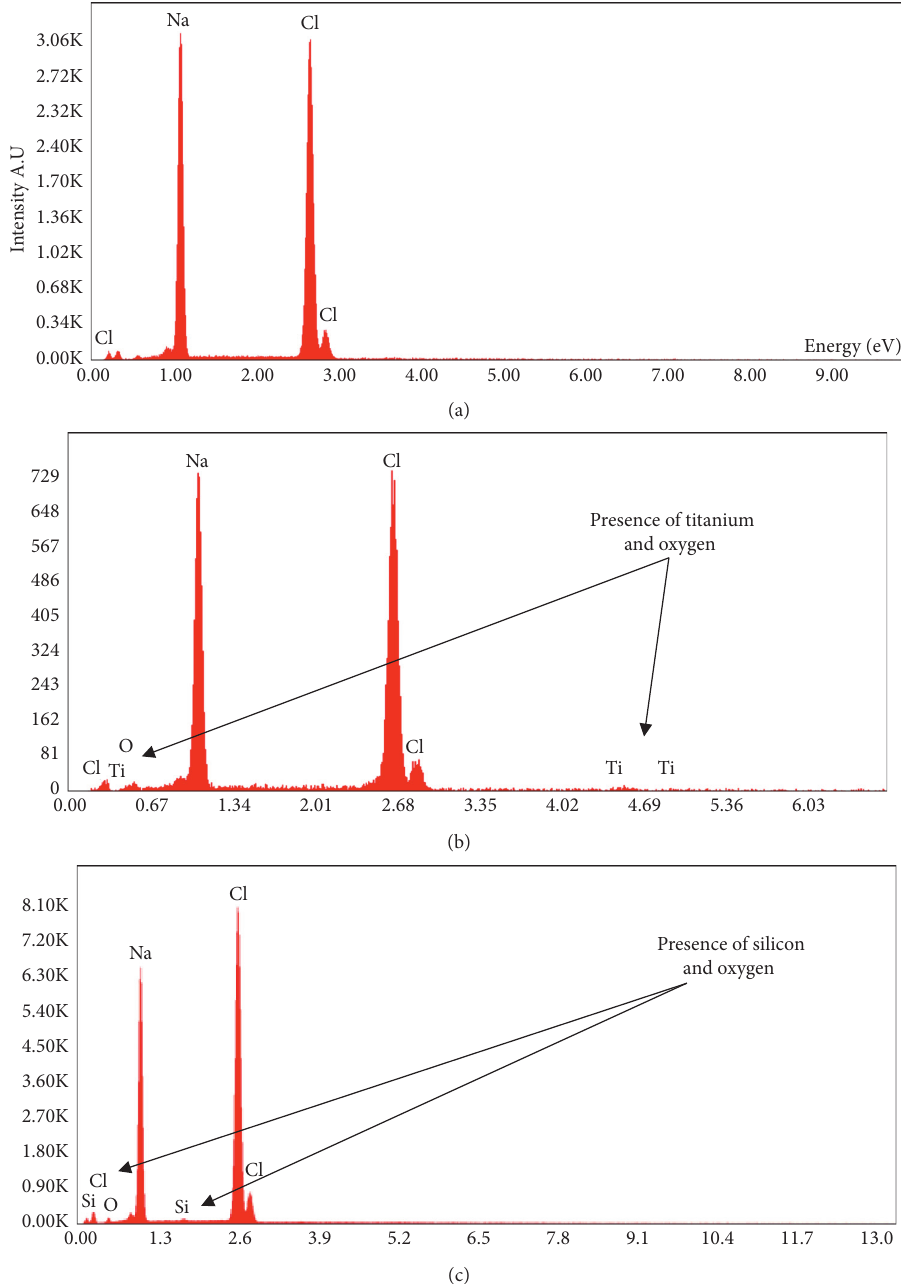
Figure 4: EDS spectra of (a) reduced size NaCl, (b) NaCl-TiO